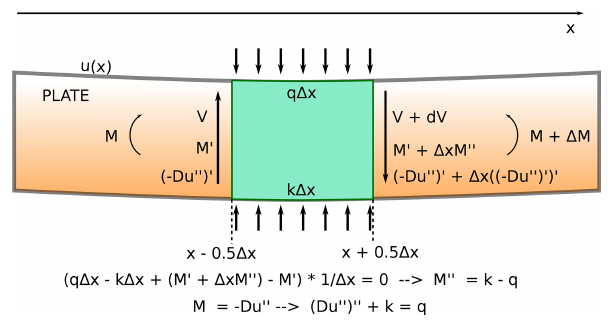
Figure 1. The force balance across a segment of a plate, (cid:49)x , and the derivation of the fourth-order differential equation describing elastic flexure. The segment is supported from below by mantle restoring forces ( k(cid:49)x ) and loaded from above by a distributed load q(cid:49)x . Shear stress V is equal to the first derivative of the moment M (cid:48) , which in turn is equal to the coefficient D multiplied by the second derivative of deflection of the plate u (cid:48)(cid:48) . Over the small distance, between x − 0 . 5 (cid:49)x and x + 0 . 5 (cid:49)x , the flexural bending equation given above